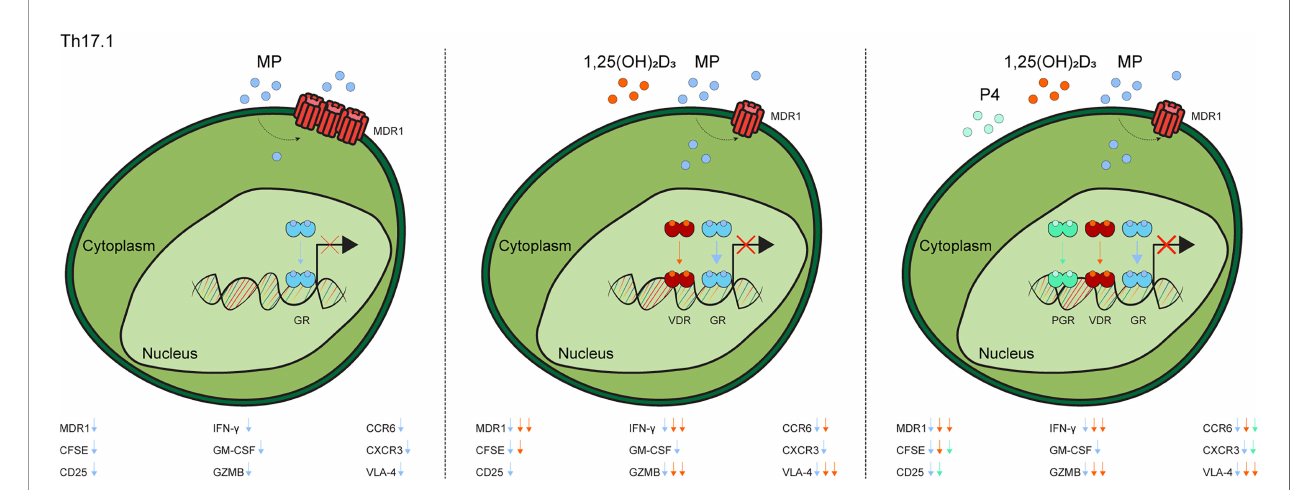
FIGURE 3 | Graphical model of the additive value of 1,25(OH) 2 D 3 and progesterone on methylprednisolone-induced suppression of Th17.1 cells. In contrast to when Th17.1 are only exposed to MP, treatment with 1,25(OH) 2 D 3 lowers their MDR1 expression and thus increases GR-signaling, thereby providing some or optimal inhibition of pathogenic markers. Addition of P4 leads provides additional suppression of some pathogenic markers. The exact modulated markers are given in each sub fi gure. “ 1,25(OH) 2 D 3 = calcitriol ” , “ CFSE ” , Carboxy fl uorescein Succinimidyl Ester; “ MDR1 ” , multidrug resistance protein 1; “ MP ” , methylprednisolone ” ; “ GR, glucocorticoid receptor ” ; “ GZMB ” , granzyme B; “ P4, progesterone ” and “ PGR, progesterone receptor ” and “ VDR, vitamin D receptor ”